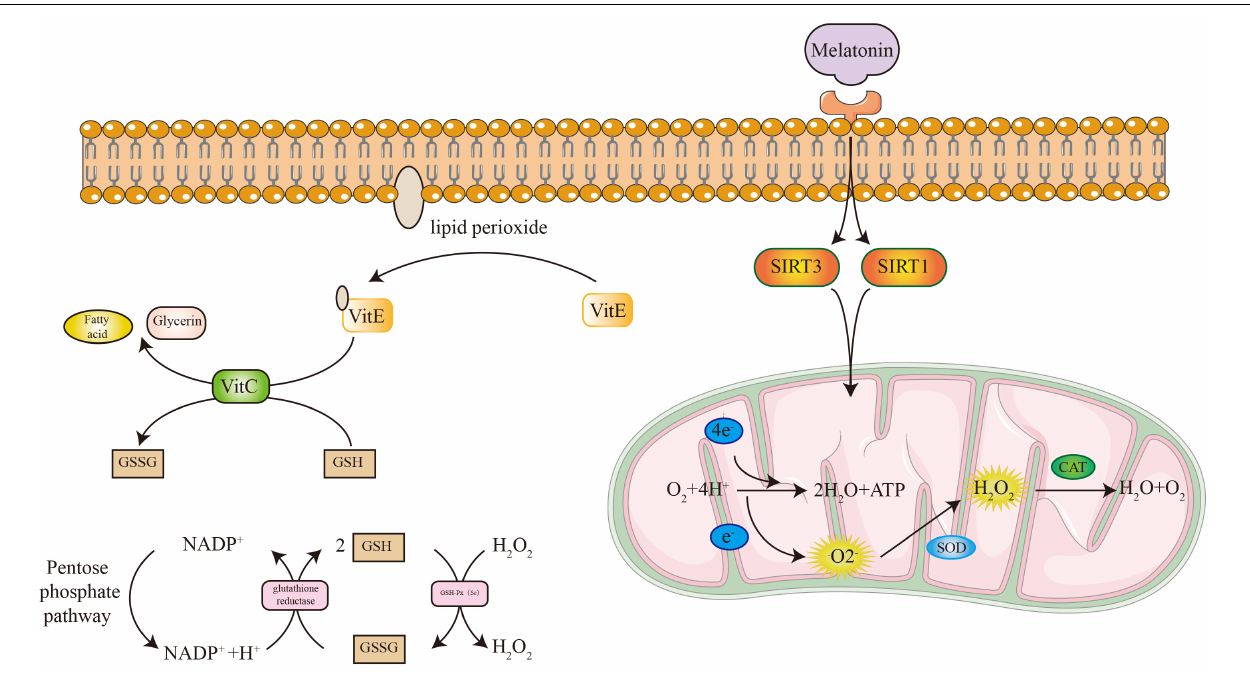
FIGURE 5 | The process of antioxidant systems to eliminate free